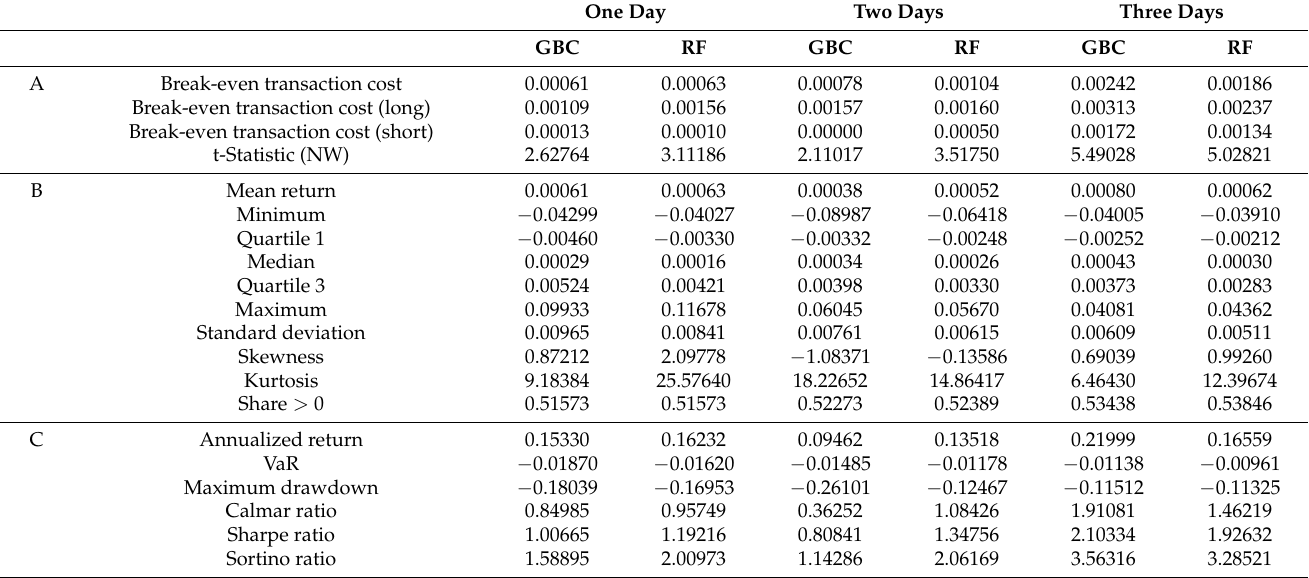
Table 3. Strategy performance for varying holding periods. Break-even transaction costs (Panel A), daily return char- acteristics (Panel B) and risk-return metrics (Panel C) for the gradient-boosting classifier (GBC) and random forest (RF). Performance characteristics are illustrated for the top/flop three ( k = 3 ) trading strategy and holding periods of one ( h = 1 ) , two ( h = 2 ) and three ( h = 3 ) days. NW denotes Newey–West standard errors with one-lag correction. VaR is calculated at the 95.0 percent confidence